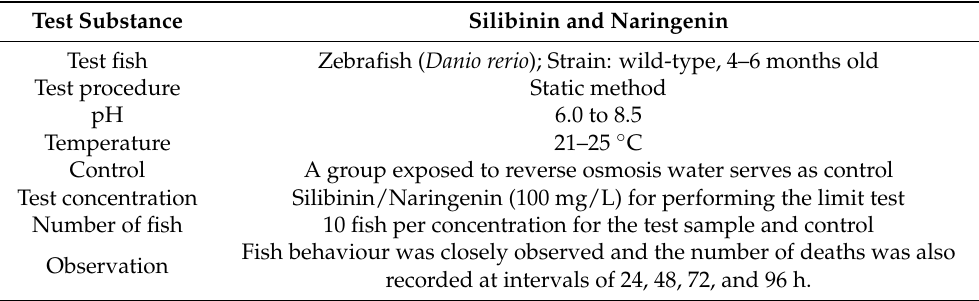
Table 1. Acute toxicity test conditions for the limit test of OECD TG 203.